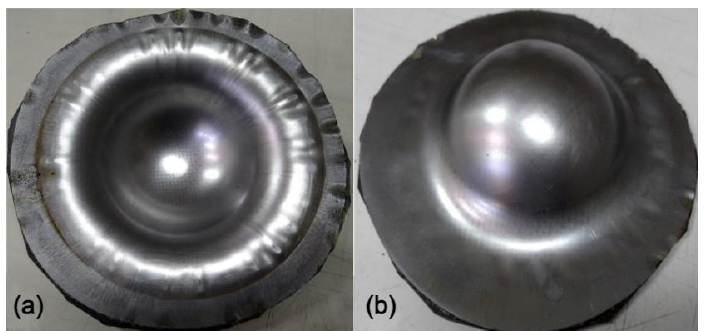
Figure 15. Deep drawing of steel-composite sandwich with blank-holding pressure of 2.5 MPa: ( a ) front view, ( b ) back view.